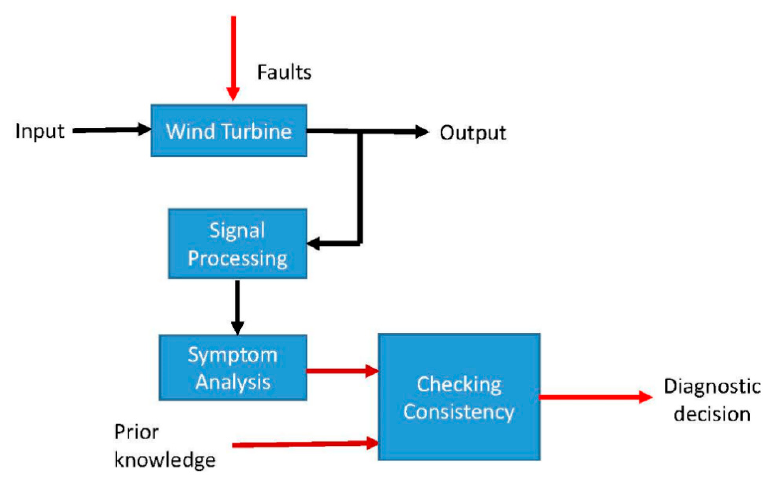
Figure 5. Schematic diagram of signal-based fault diagnosis.